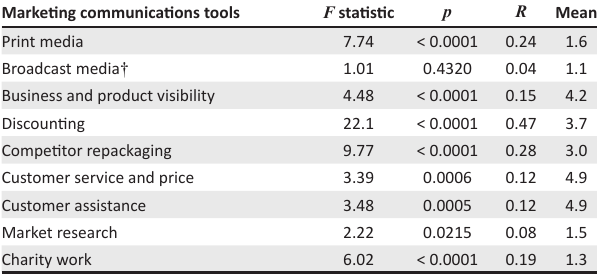
TABLE 4: Interaction model results and coefficient of determination for marketing communication